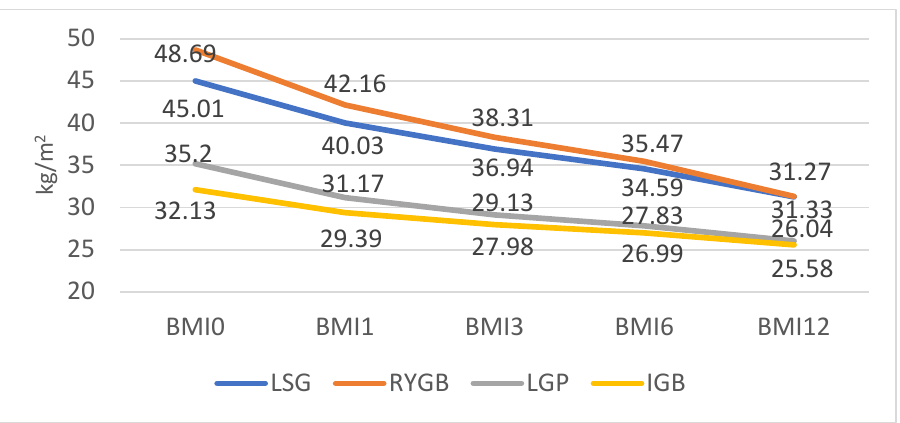
sion was identified in 61.4% of patients. Plotting the ROC curve, it is highlighted that neither the preoperative weight (G0-AUC = 0.493; 95% CI: 0.433–0.553; p = 0.819) nor the excess weight (EW-AUC = 0.527; 95% CI: 0.469–0.586; p = 0.369) were good predictors for partial or total remission of T2DM (Figure 4). Fasting glucose levels at 12 months in the presence or absence of glucose-lowering pharmacologic treatment were used to define total or partial